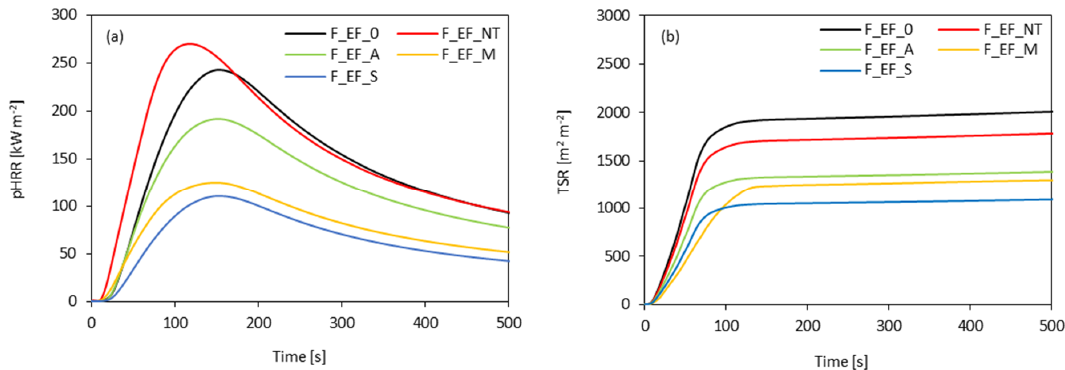
Figure 15. ( a ) peak heat release rate (pHRR) and ( b ) total smoke release (TSR) values obtained for polyurethane foams modified with eucalyptus